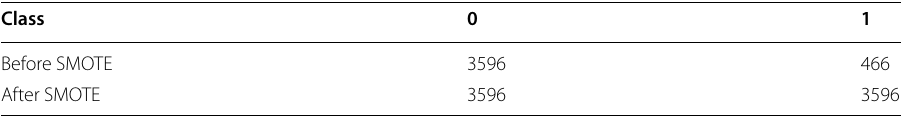
Table 5 Framingham dataset oversamplig results Class